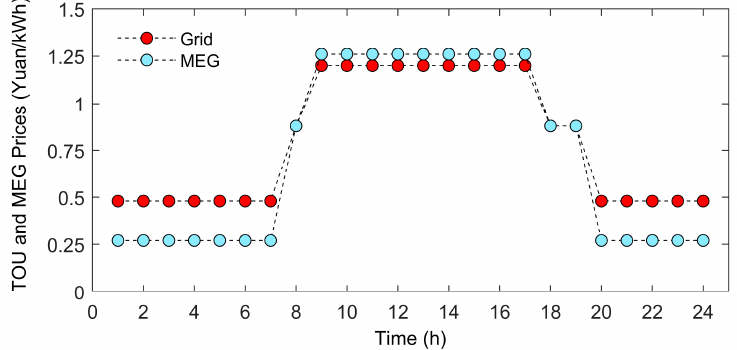
Figure 5. The time of use (TOU) and the MEG selling electricity prices.